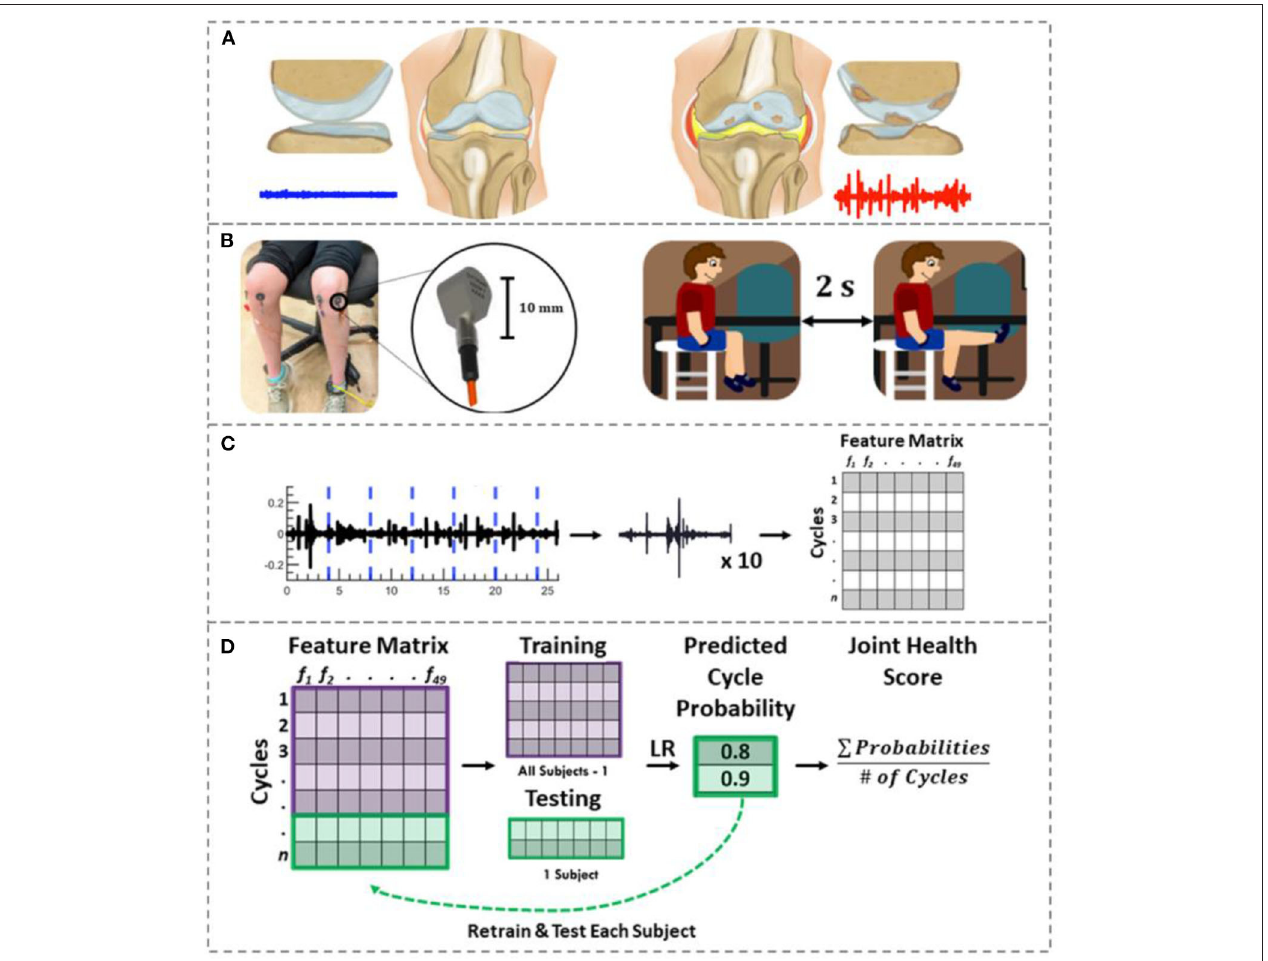
FIGURE 1 | Joint acoustic emission overview. (A) A healthy knee articulates smoothly due to its smooth cartilage and appropriate amount/constituency of synovial fluid. This smooth articulation creates a noise-like JAE (blue). In JIA, thickened/inflamed synovium with excessive joint effusions, cartilage loss and/or bone erosions may be observed. These changes are hypothesized to create a JAE with several large spikes (red). (B) To record the knee JAEs, two contact accelerometers were placed on each child’s knees. They viewed and replicated the movements in an instructional cartoon during JAE recording such that their movement speed and range of motion was controlled. (C) The resulting JAEs were split into their approximately ten component cycles. Forty-nine features were calculated to describe these cycles. The features, subject numbers, and clinically determined disease status were fit to a feature matrix. (D) Using logistic regression and LOSO-CV, the probability of each cycle belonging to JIA were calculated. The average of those cycle probabilities is used as a “joint health score” to indicate the severity of JIA. If the majority of cycles for a given subject had a probability of JIA ≥ 0.5, that subject was classified as having